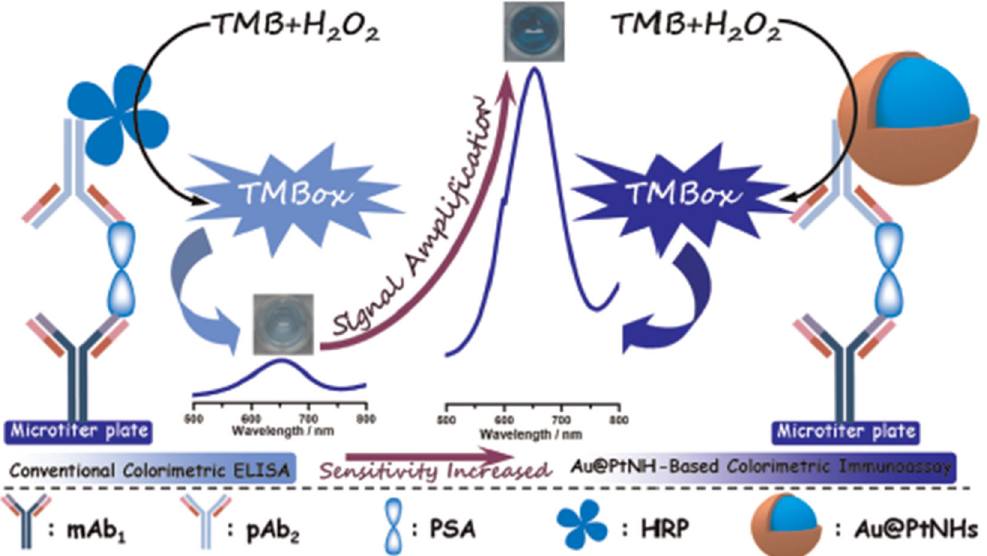
Figure 5. Schematic illustration of conventional colorimetric enzyme-linked immunosorbent assay (left) and Au@Pt nanohybrid-based immunoassay. Reprinted with permission from [37]. Copyright © 2015 Elsevier.